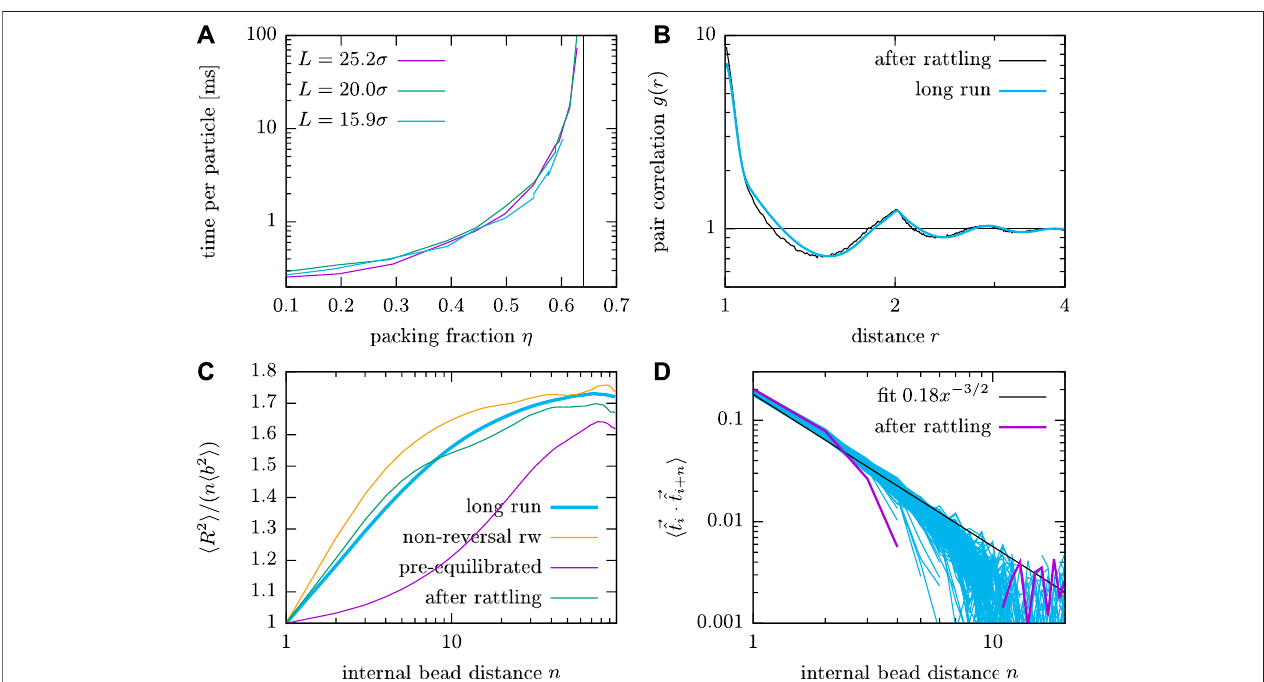
FIGURE 7 | (A) Wall time per particle to generate rattled con fi gurations of variable polymer number M with a fi xed length of N (cid:2) 200. The wall time scales linearly in the numbers of particles, i.e., curves for different system sizes L × L are identical and diverge when the packing fraction η (cid:2) MN ( π / 6 )( σ 3 / L 3 ) approaches the random closed packed limit η rcp ≈ 0 . 64(indicated asvertical line). Preparation ofeven largersystems( M × N (cid:2) 10 6 ) formoderate η ( ≈ 0 . 4)take only ≈ 10 3 s.Preparation ofpure hardsphere systems( N (cid:2) 1)areroughlytwiceasfast. Forthefollowingweuse M (cid:2) 1000chainsà N (cid:2) 100beadsat η ≈ 0 . 45( ρ (cid:2) 0 . 85 / σ 3 ,i.e., L ≈ 49 σ ).Alldatais generated on a single core of a i7-8650U (B) The pair correlation g ( r ) is sensitive to the local structure of the hard spheres and resembles the equilibrium measurement quitewell.Thewarm-uptakesonlyacoupleofminutes (C) Theinternalbead-to-beaddistance 〈 R 2 〉 / ( n 〈 b 2 〉 ) captureshowwellthepolymersareequilibratedandhasto beasclosetotheequilibriumresultaspossiblebecausethisobservableequilibratesveryslowly.Forequilibrationachainneedstomoveitsownsize,whichisslowdueto reptational dynamics. Because of strong fl uctuations the warm-up times have not been measured precisely, but are of the order of a couple of hours (D) The tangent correlation shows the correct non-ideal behavior of chains in the melt [42, 43]. The con fi guration after rattling resembles the equilibrium quite well. The warm-up takes only a couple of